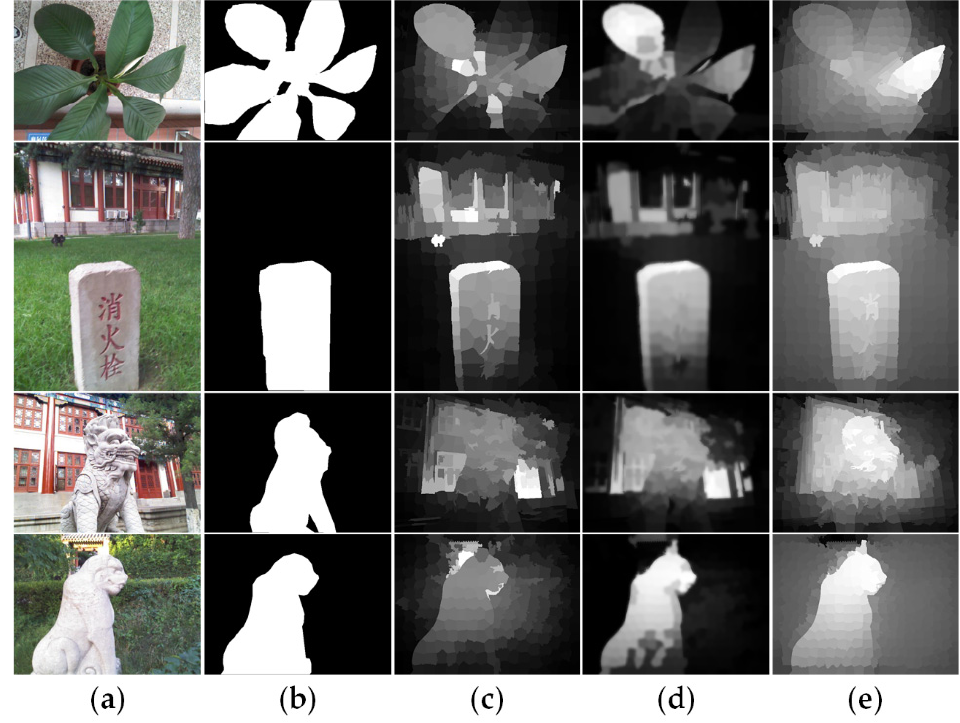
Figure 2. Traditional saliency detection models based on absorbing Markov chain. ( a ) RGB images. ( b ) Ground truth. ( c ) Saliency maps generated by [ 45 ] . ( d ) Saliency maps generated by [ 46 ] . ( e ) Saliency maps generated by [ 44 ] .